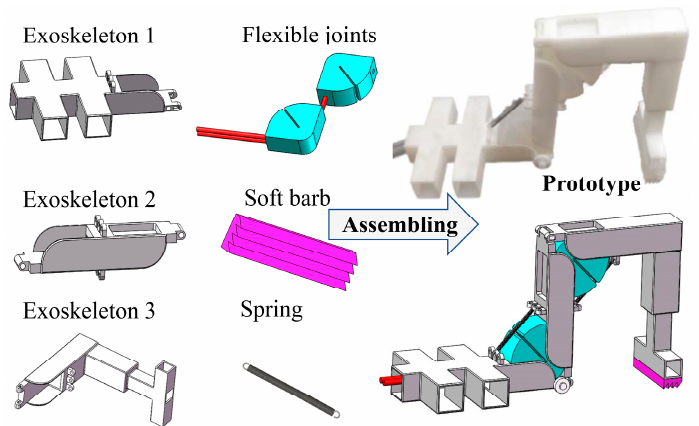
Figure 5. Assembling of the soft arthropod robot. (Including three exoskeletons produced by the stereolithography 3D printer, two springs, a soft barb, and two flexible joints made of silica gel).